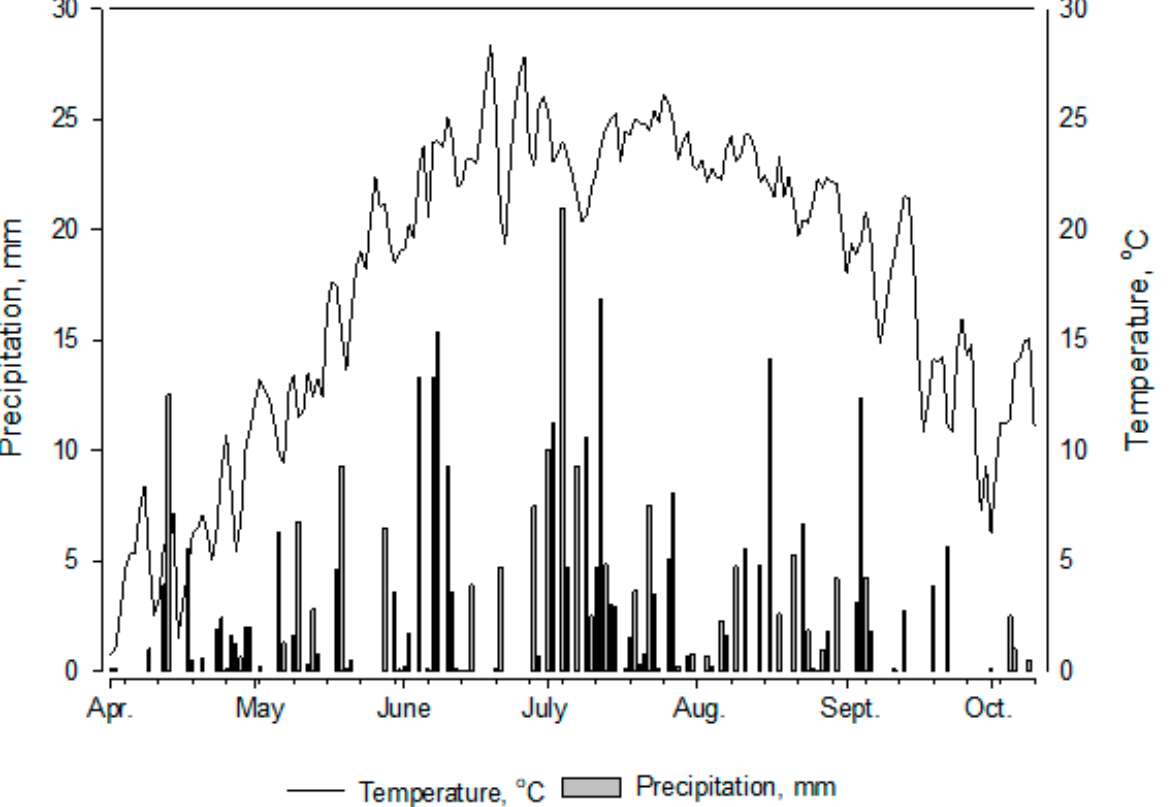
Figure 5. Average air temperatures and precipitation in the season 2010–2016, Hailun Meteorological Station, China.